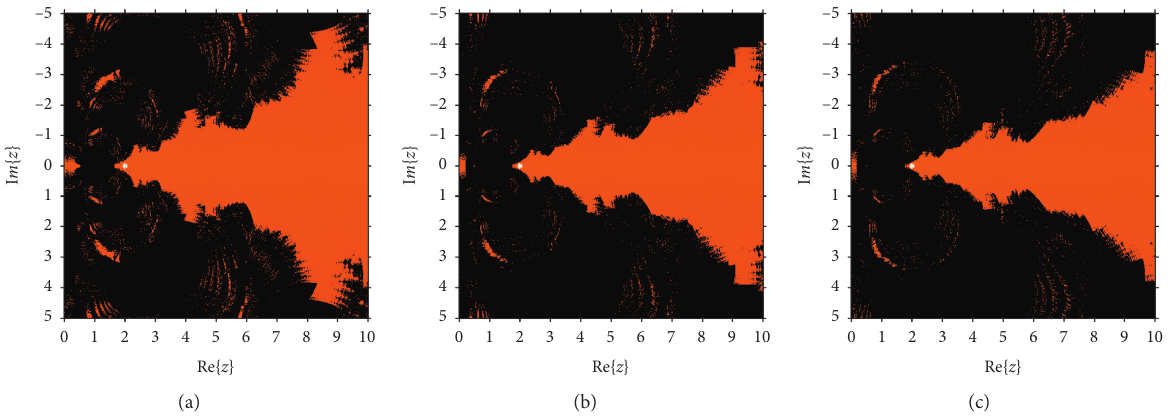
Figure 13: Basins of attraction of (a) BM1, (b) AM2, and (c) ZM3 for g